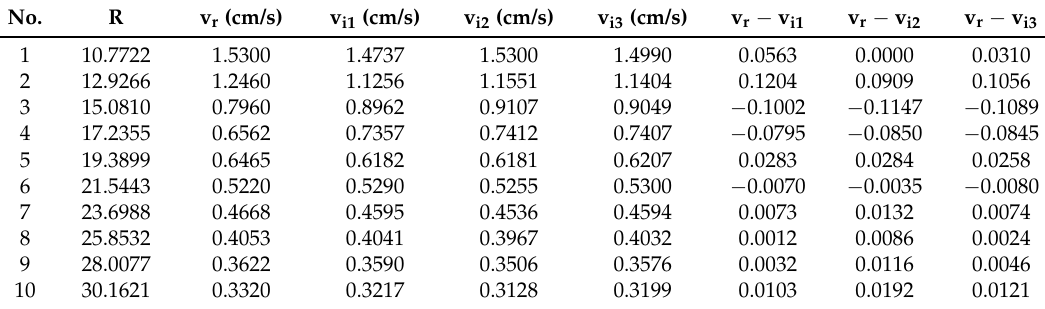
Figure 4. Graphic survey of soil oscillation law curve in the Veliki Krivelj Open Pit.